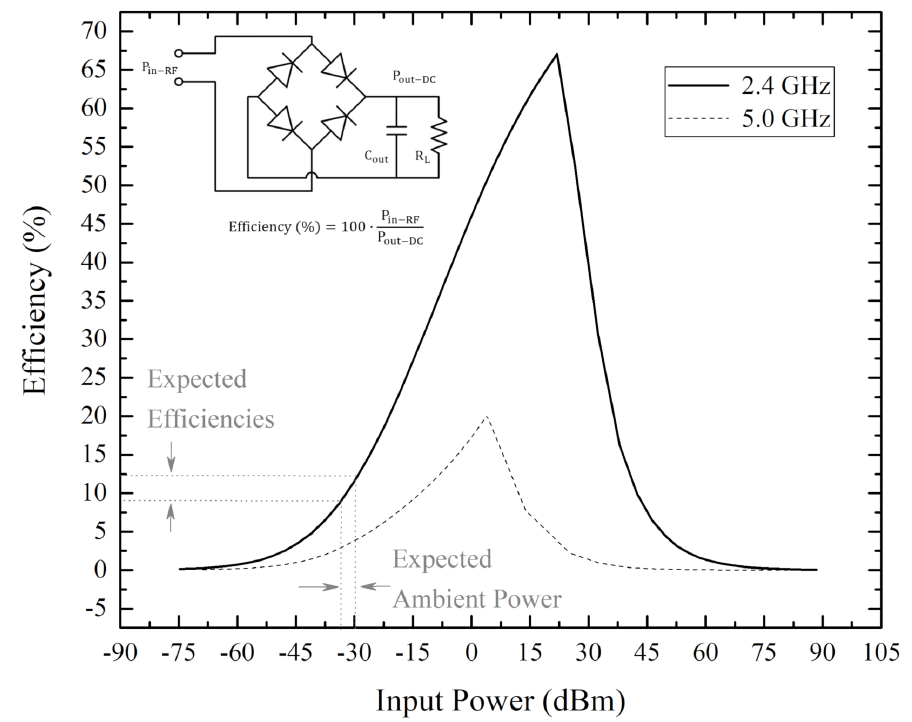
Figure 11. Simulated efficiencies of a SMS7630 diode bridge rectifier where C out = 6.8 mF. R L = 32 k Ω is the measured input impedance of the EMS. The analysis has been done using ADS harmonic balance simulation to estimate the ratio between RF input power (P in − RF ) and the DC output power delivered to the load (P output − DC ) .